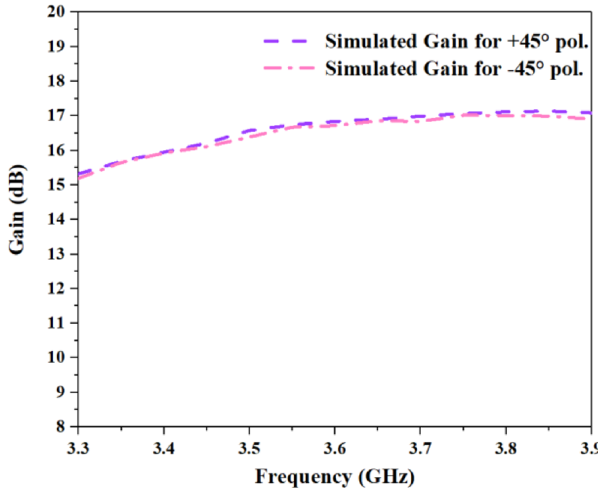
Fig. 9. Simulated gain of the proposed antenna